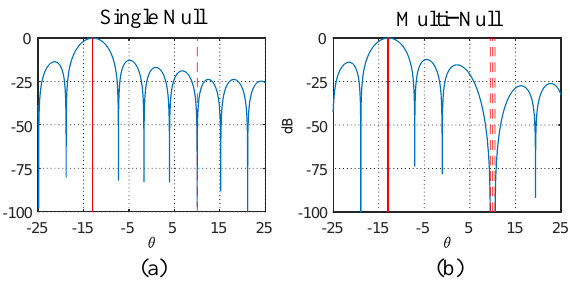
Figure 8. ( a ) A single null constrained beam pattern. ( b ) A multi-null constrained beam pattern.